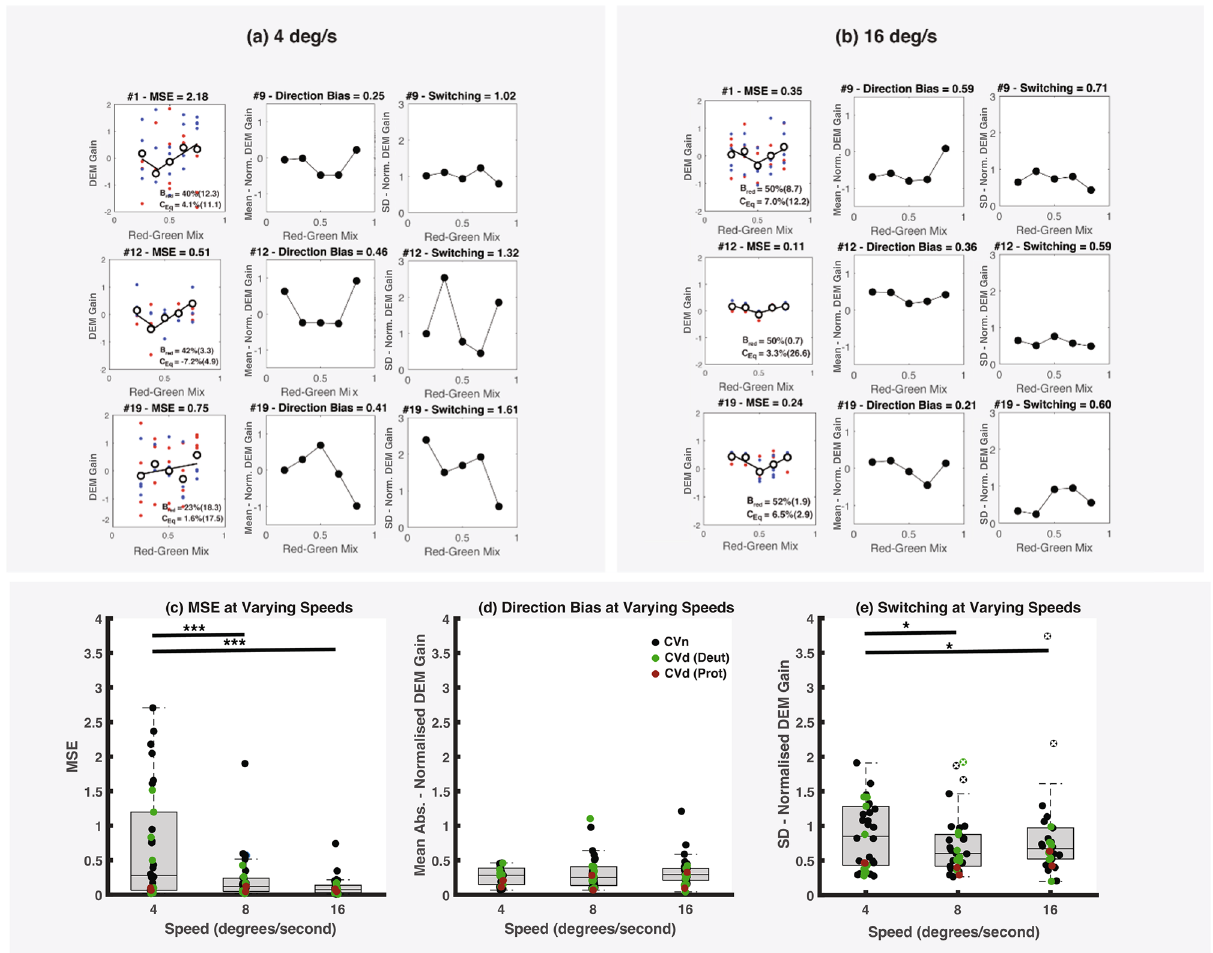
Figure 9. ( a , b ) ‘V’ functions of the 3/6 CVn participants that were misclassified (based on results from the 4 deg/s conditions) for both ( a ) 4 and ( b ) 16 deg/s conditions. Stimuli moving at 4 deg/s elicit higher but inconsistent DEM gain (as measured by the MSE). More consistent but lower DEM gains are elicited by faster stimuli which leads to more robust fits of the ‘V’ function centred around B Red = 50%. ( c ) MSE of the V-fit across speed conditions. The mean MSE at both 8 and 16 deg/s are statistically significantly lower than measures made at 4 deg/s. ( d ) Box and whisker plot indicate little difference in absolute direction-bias across the different test-speeds. ( e ) Switching magnitude plot across speed conditions. There is significant difference in mean SD of DEM-gain for both 8 deg/s and 16 deg/s compared to 4 deg/s. Note that outlier analysis has been applied by removing data (indicated by crosses) that is more than three scaled median absolute deviations (MAD) away from the